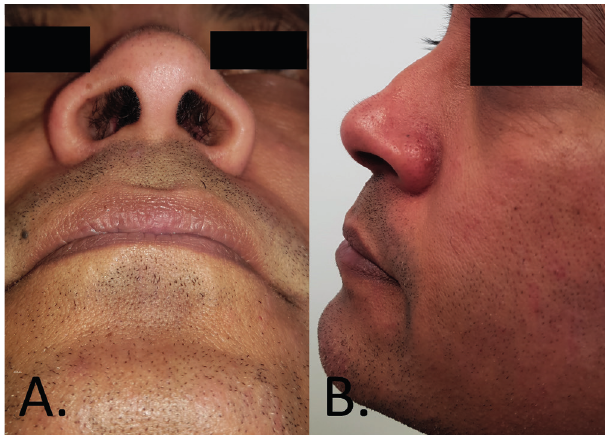
Figure 2. Appearance of nose at 8 weeks post incision and drainage. A. complete resolution of septal swelling and obstruction. B. Resultant dor- sal nasal saddle